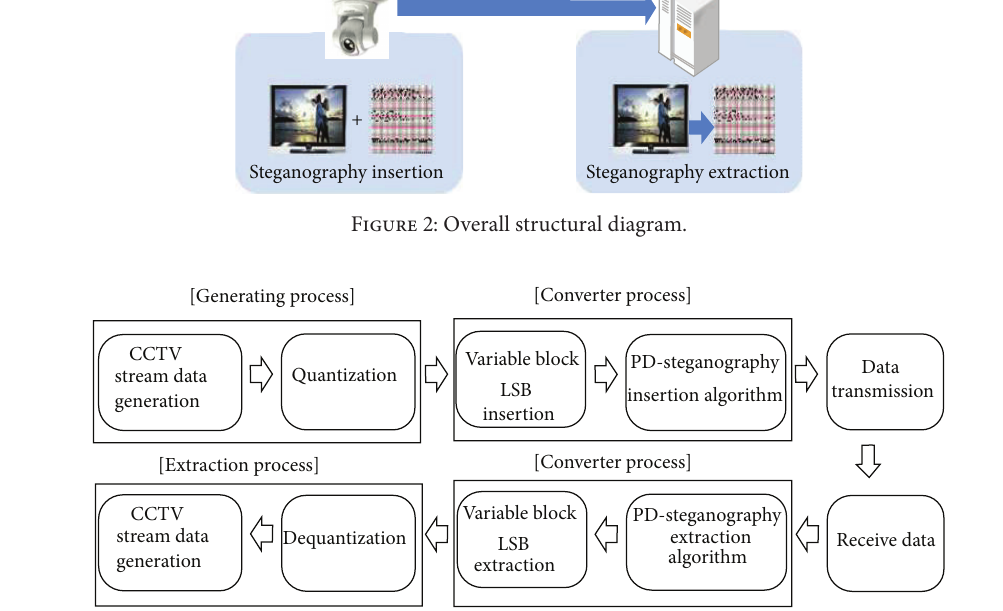
Figure 3: Overall data